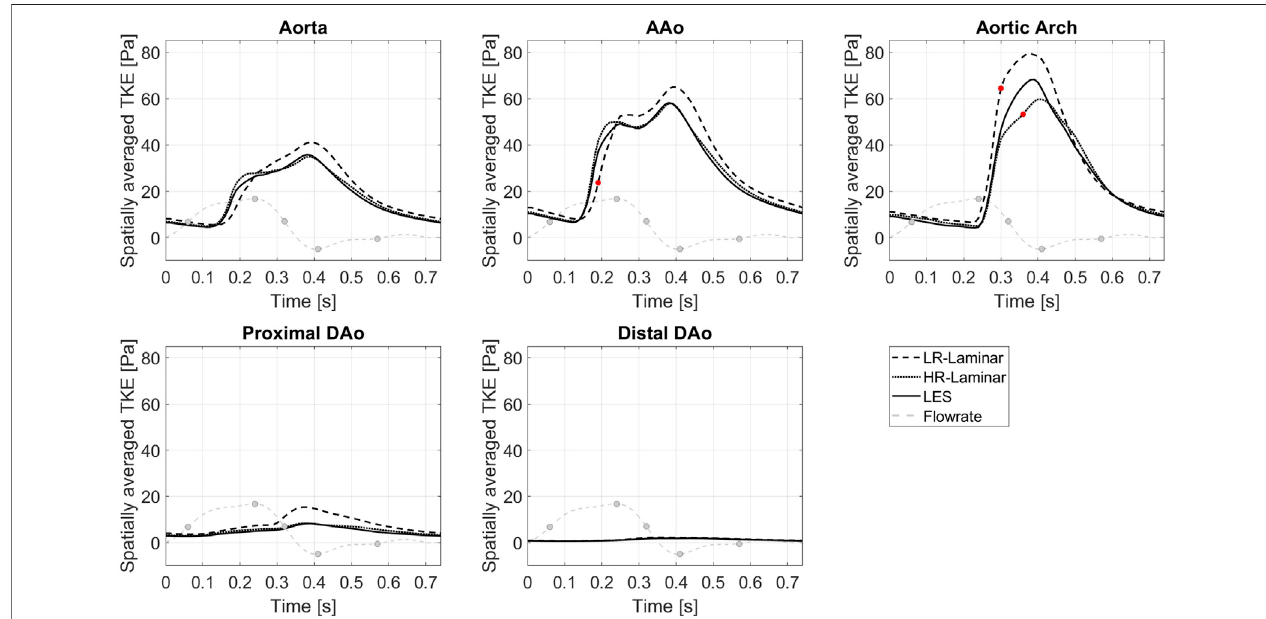
FIGURE 4 | TKE spatially averaged over the entire aorta and each ROI, plotted over the cardiac cycle. Largest differences relative to LES are indicated by red markers.Keytimesthroughoutthecardiaccycleareindicatedbygreymarkersandrefertomaximumacceleration,peaksystole,maximumdeceleration,endsystoleand mid-diastole.